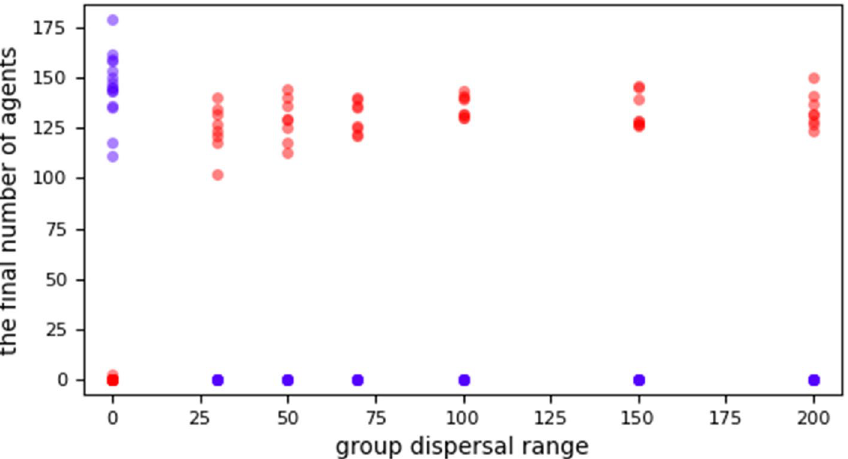
Figure 1. The final numbers of cheaters (red dots) and cooperators (blue dots) at different group dispersal ranges: cheaters could thrive only when they started to share the dispersal costs to some degree. However, when the group dispersal range = 0, each cheater pays the dispersal costs by itself. Therefore, cheaters cannot arrange successful migrations and cannot violate the spatial structure mechanism. Hence, they encounter local extinction at their